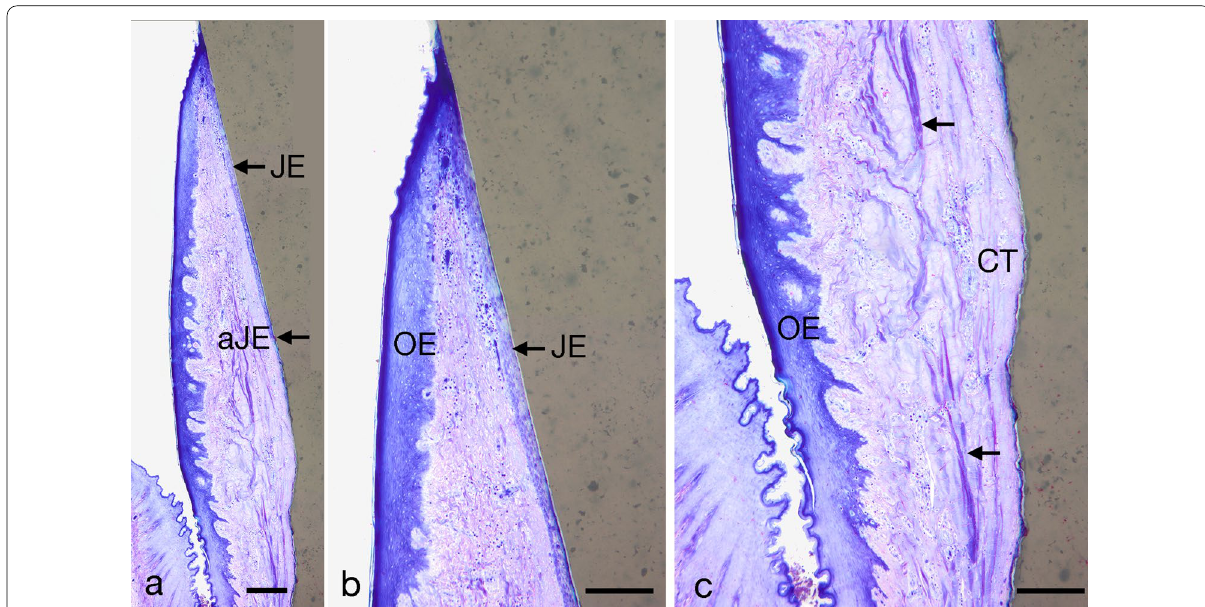
Fig. 6 LM micrographs revealing the buccal peri-implant mucosa after 8 weeks. a Note the intimately adherent junctional epithelium (JE) and its apical end (aJE). b Higher magnification of a . Note the keratinized oral epithelium (OE) and the non-keratinized junctional epithelium (JE). c Note the collagenous fibers (black arrows) in the peri-implant connective tissue running parallel to the implant surface. Scale bars: 300